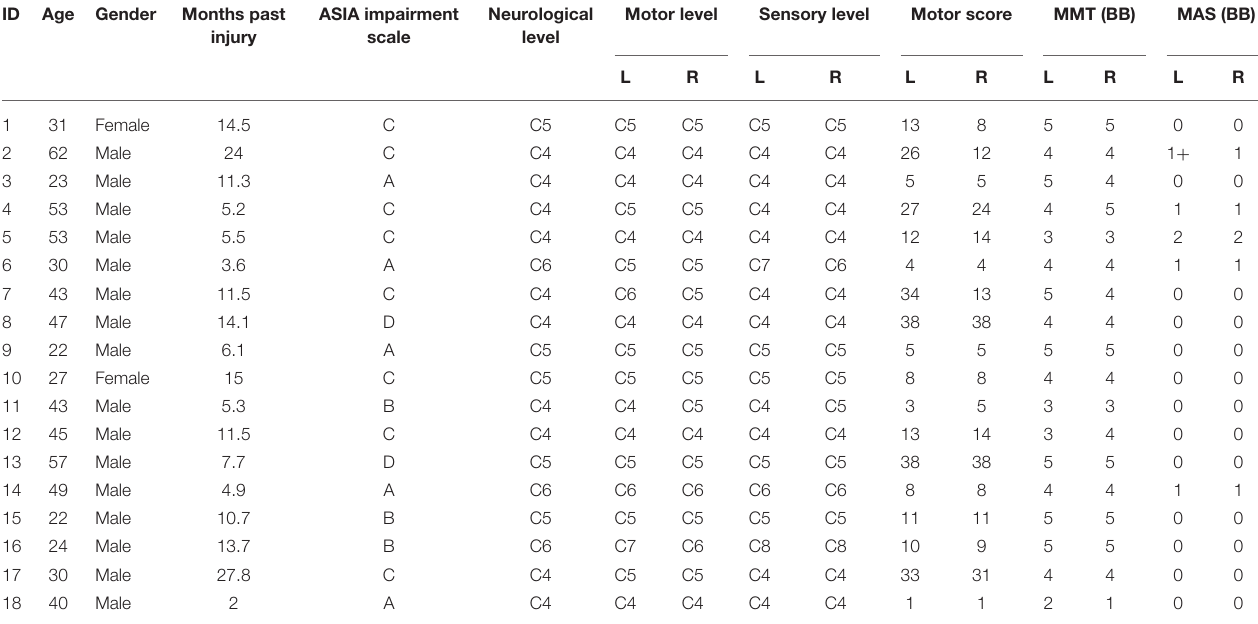
TABLE 1 | Baseline characteristics of the patients with spinal cord injury (SCI). ID Age